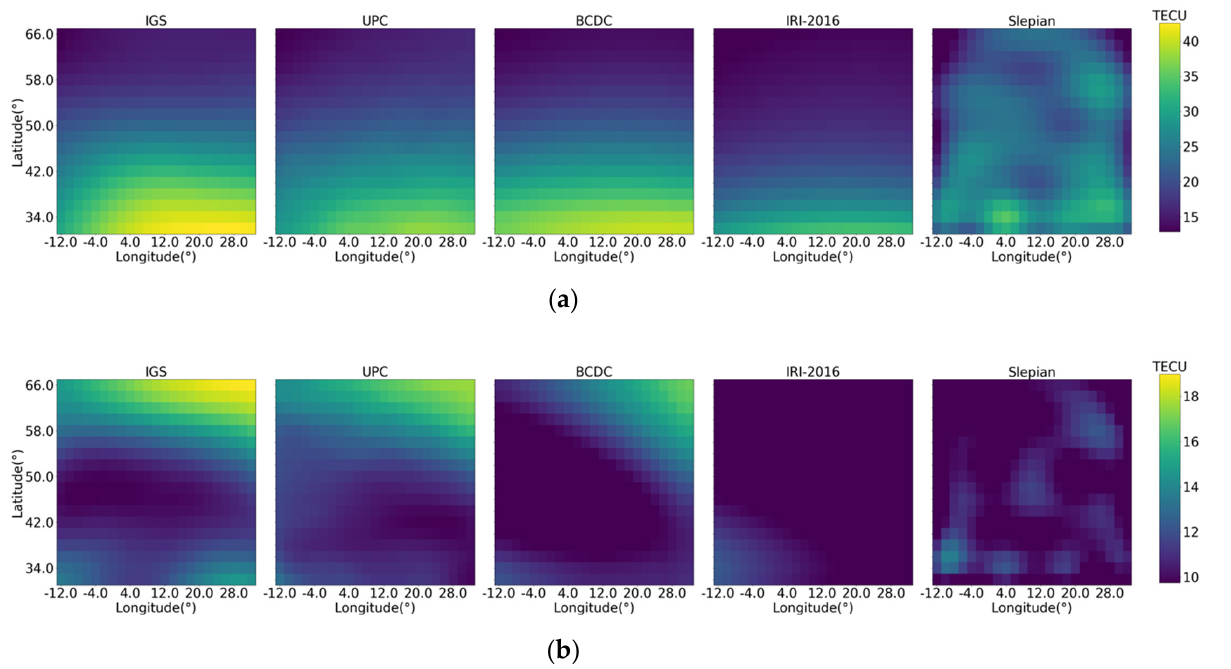
Table 3. The overall RMSE and ∆𝑅𝑀𝑆𝐸 of the H m F 2 parameter (unit: km) achieved by the three methods.